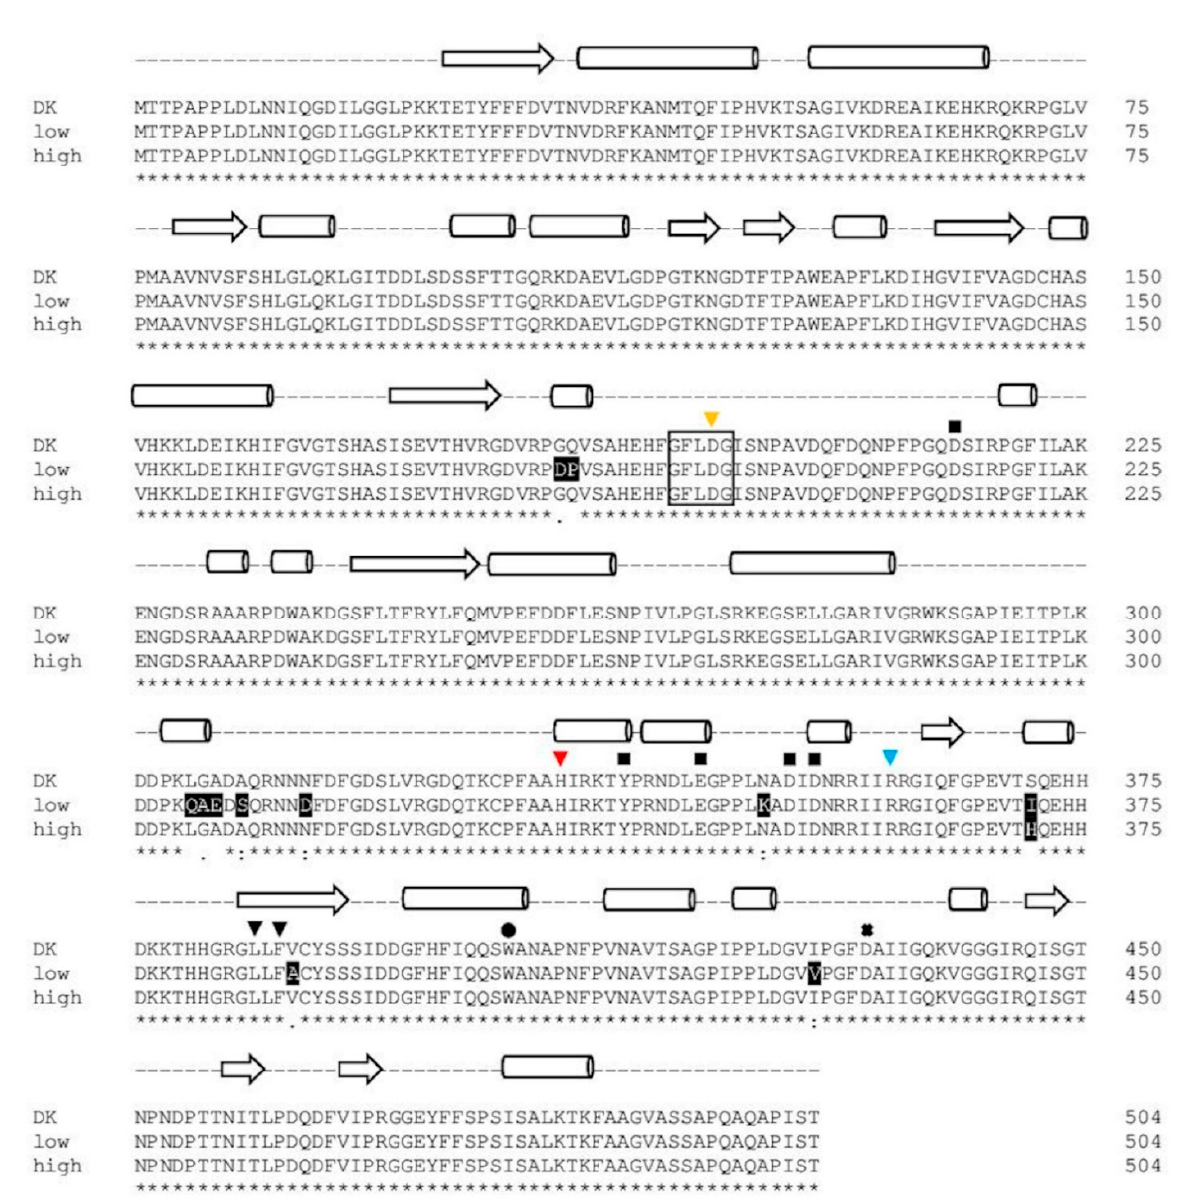
Figure 5. Alignment of the amino acid sequence of the PsaPOX variants. DK: PsaPOX_DK; low: PsaPOX_low; high: PsaPOX_high. Inverted triangles show amino acids important for heme binding (H334 (red) functions as ligands for heme and the four other amino acid residues form a hydrogen peroxide binding pocket). Aspartic acid (D433), which